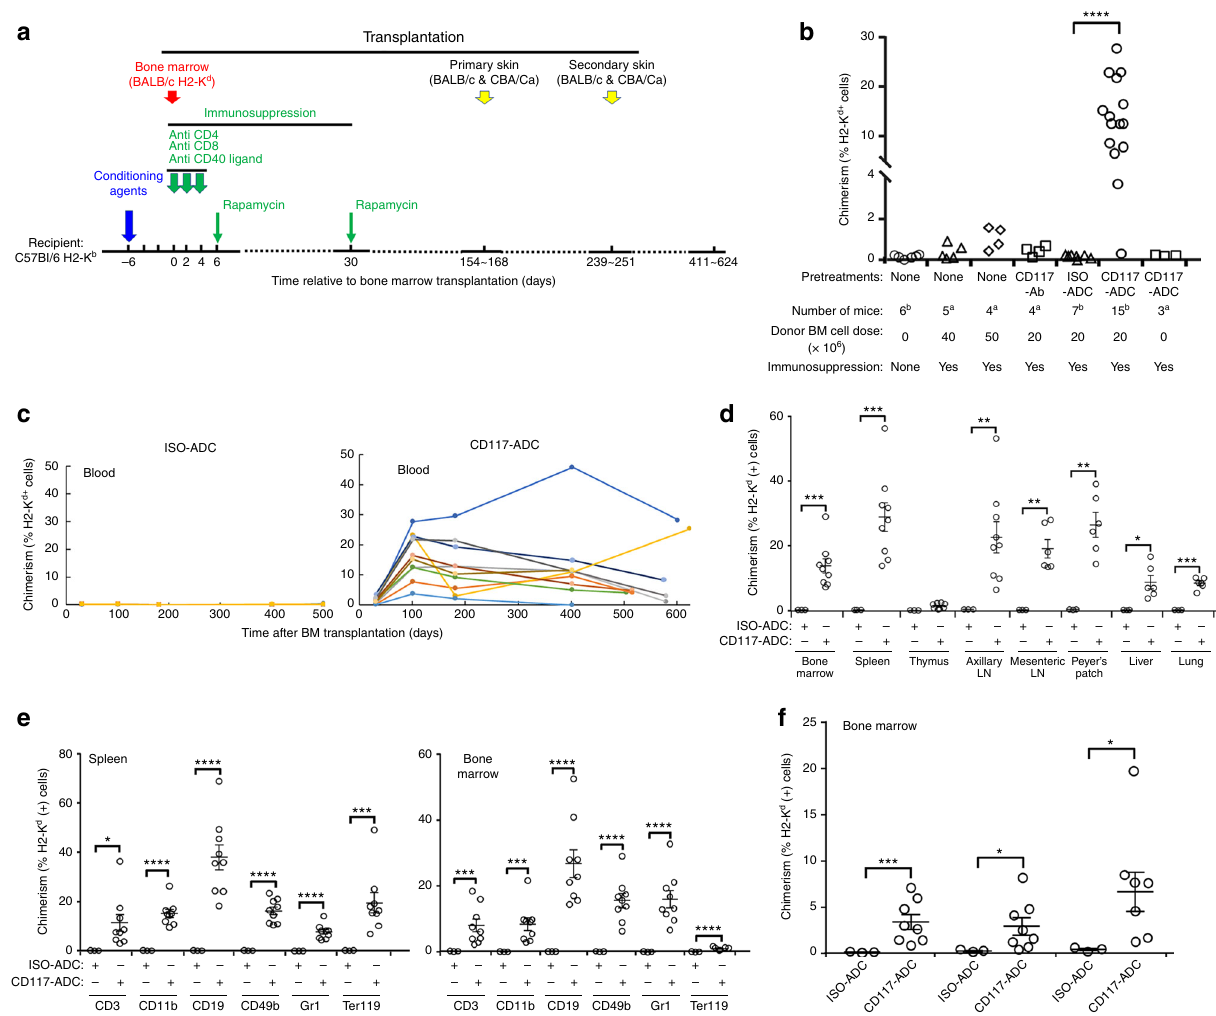
Fig. 1 Robust hematopoietic chimerism after CD117-ADC conditioning and transient immunosuppression in fully MHC-mismatched BM allotransplantation. a Experimental protocol. b – f Abbreviations: ADC , antibody-drug-conjugate; CD117 , anti-CD117 mAb; ISO , isotype control mAb. b Donor peripheral blood chimerism showing CD117-ADC ef fi cacy. Data are from day 100 post BMT and are summarized as the mean ± SEM from one ( a ) or two ( b ) independent experiments. CD117-Ab, 2 animals each for unconjugated CD117 mAbs 2B8 and ACK2. The underlying FACS gating strategy is given in Supplementary Figure 4. c Engraftment time course. Each line represents an individual mouse from a single experiment. The underlying FACS gating strategy is given in Supplementary Figure 4. d Immune organ chimerism. The underlying FACS gating strategy is given in Supplementary Figure 5. e Chimerism of mature leukocytes in spleen and BM. The underlying FACS gating strategy is given in Supplementary Figure 6. f BM progenitor chimerism. LT-HSC, long-term- HSCs (Lin - Sca1 + c-Kit + CD34 lo Flt3 lo ); ST-HSCs, short-term-HSCs (Lin - Sca1 + c-Kit + CD34 hi Flt3 lo ); MPP, multipotent progenitors (Lin - Sca1 + c-Kit + CD34 hi Flt3 hi ). The underlying FACS gating strategy is given in Supplementary Figure 7. b, d – f Data are the mean ± SEM donor chimerism at termination > 500 days after BMT. Statistics calculated using unpaired parametric t -tests with Welch ’ s correction (two-tailed); all data points signi fi cant as indicated (* P < 0.05; ** P <0.01; *** P < 0.001; **** P < 0.0001). c – f Results are from one experiment representative of two independent experiments